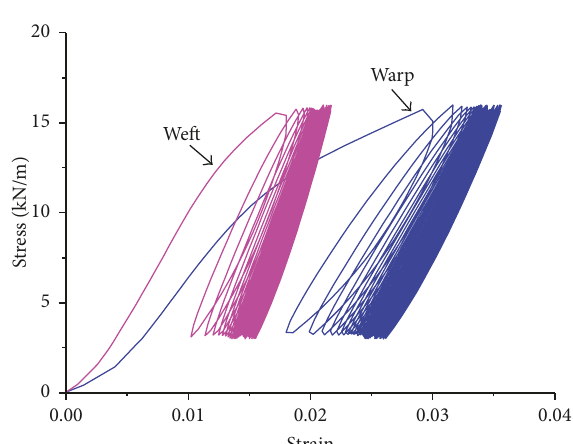
Figure 3: Tear strength and elastic modulus after different aging times.